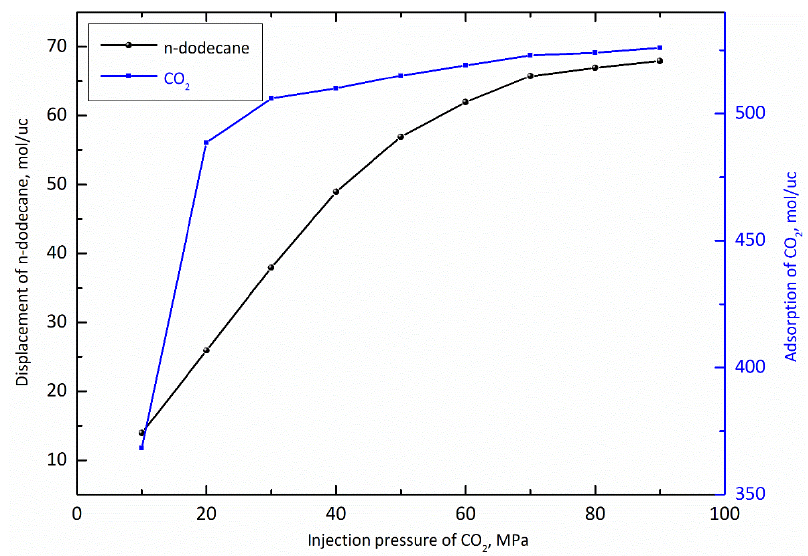
Figure 3. The molar quantity of n-dodecane displaced by CO 2 and the molar quantity of CO 2 absorbed in the pores at different injection pressure of CO 2.